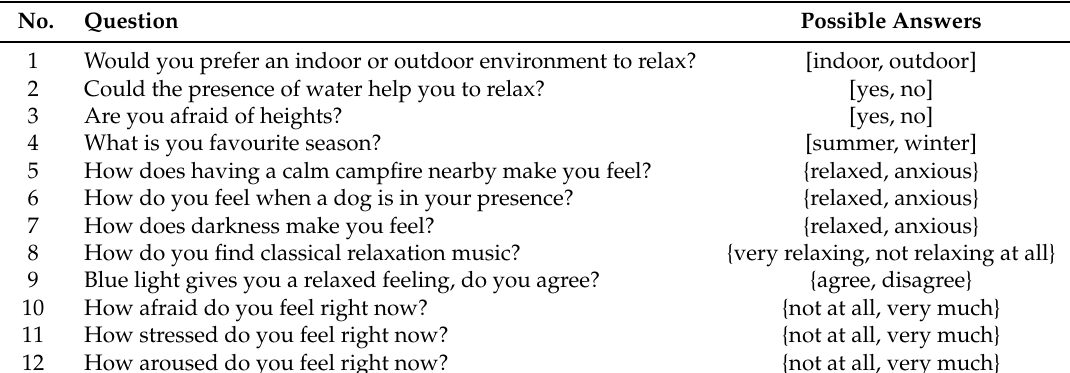
Table 2. The amount of possible answers that can be given to every question from the questionnaire.